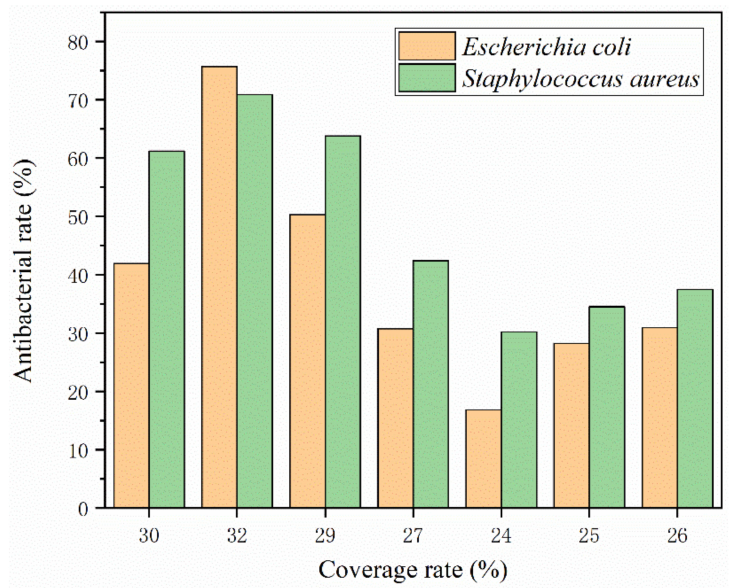
Figure 10. Relationship between coating rate and antibacterial rate.